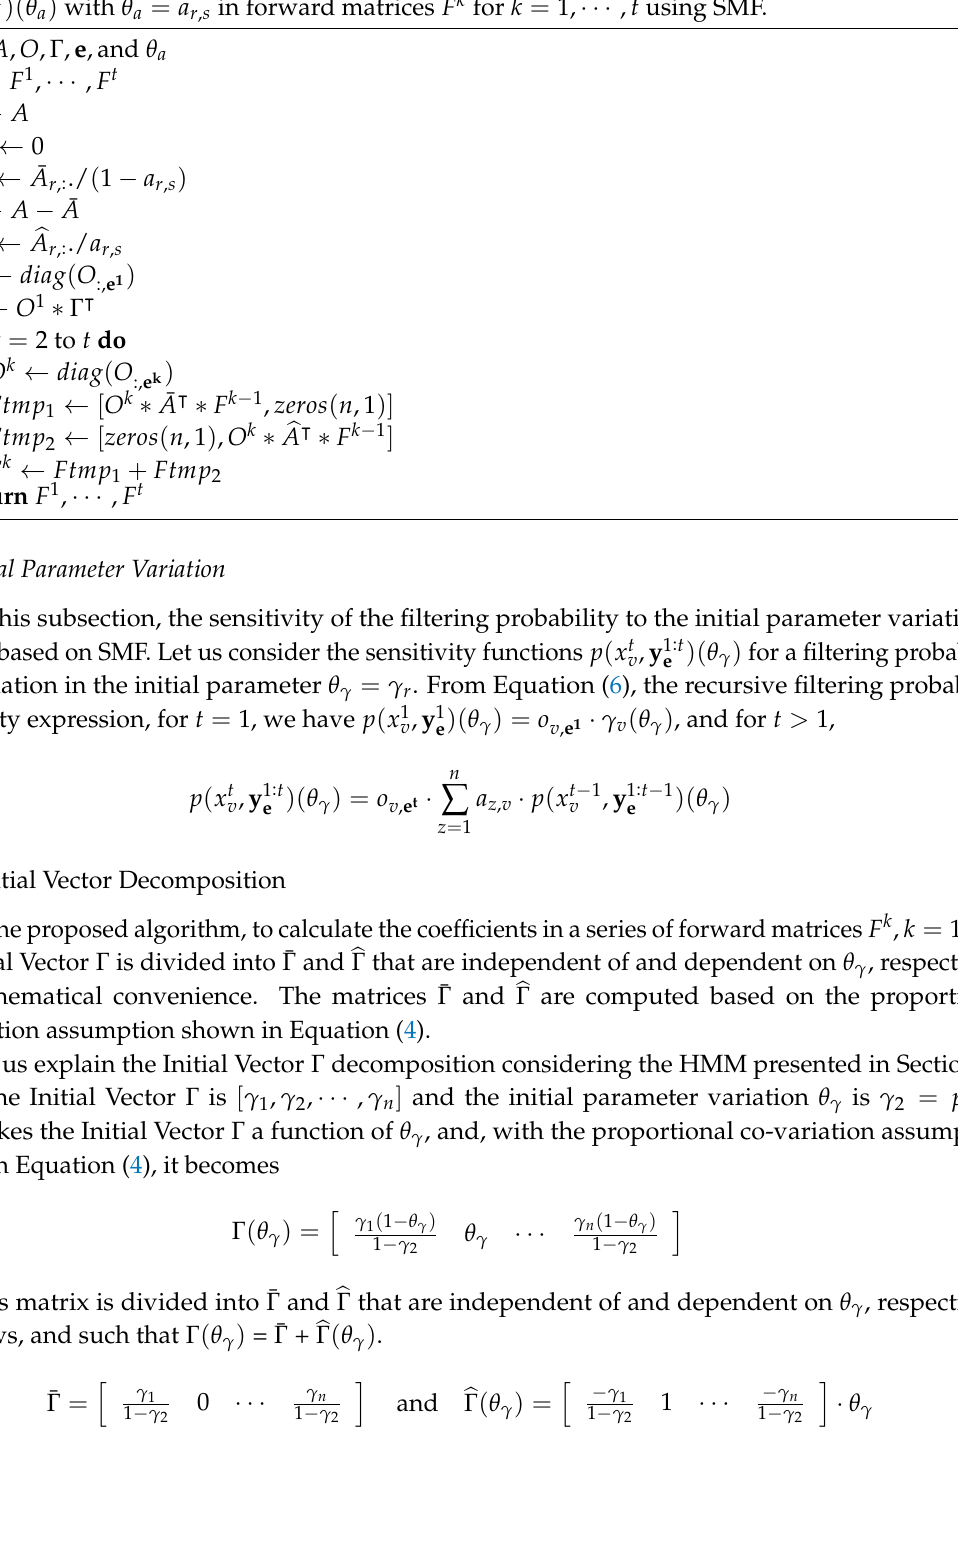
Algorithm 1 Computes the coefficients of the forward (filtering) probability sensitivity